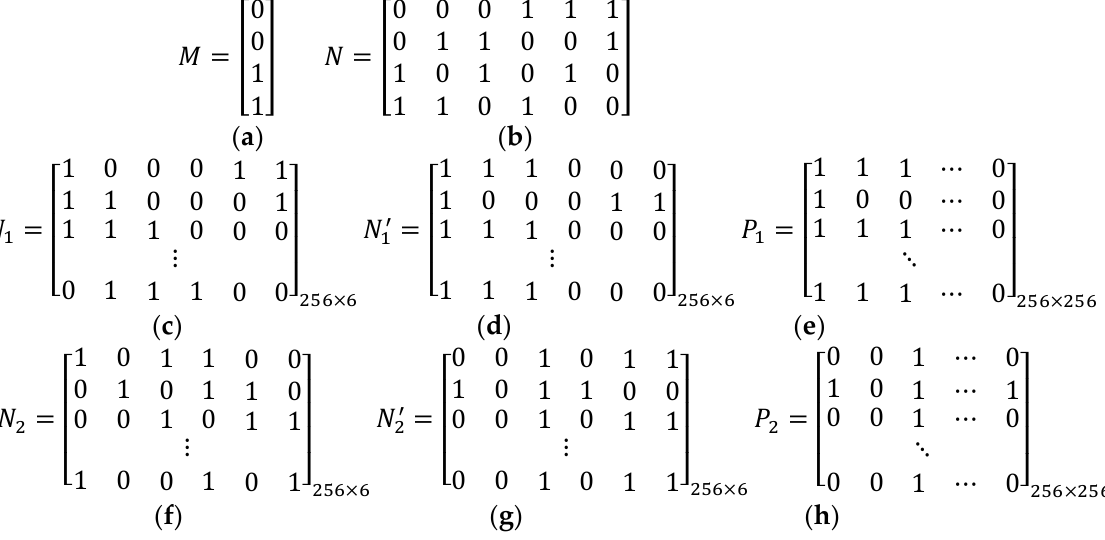
Figure 2. An example of (3, 4) thresholds sharing matrix generation method size 256 × 256: ( a ) bi- nary vector M , ( b ) initial matrix N , ( c ) extended matrix N 1 , ( d ) exchanged matrix 𝑁 1′ , ( e ) sharing matrix 𝑃 1 , ( f ) extended matrix N 2 , ( g ) exchanged matrix 𝑁 2′ , ( h ) sharing matrix P 2 .